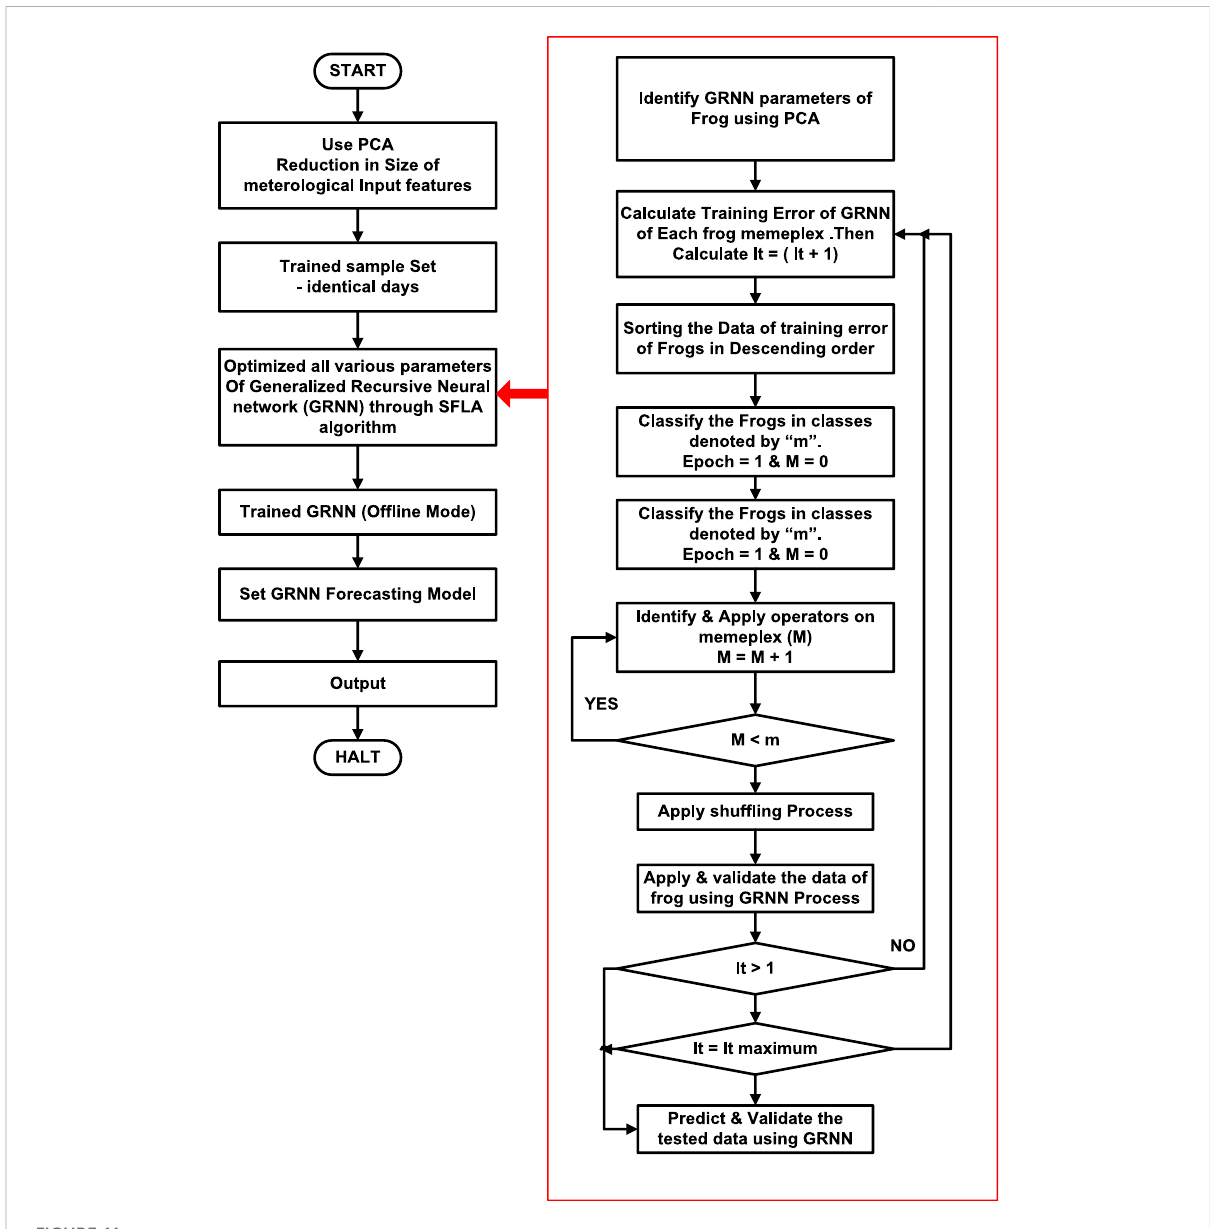
FIGURE 11 Flowchart of proposed model using